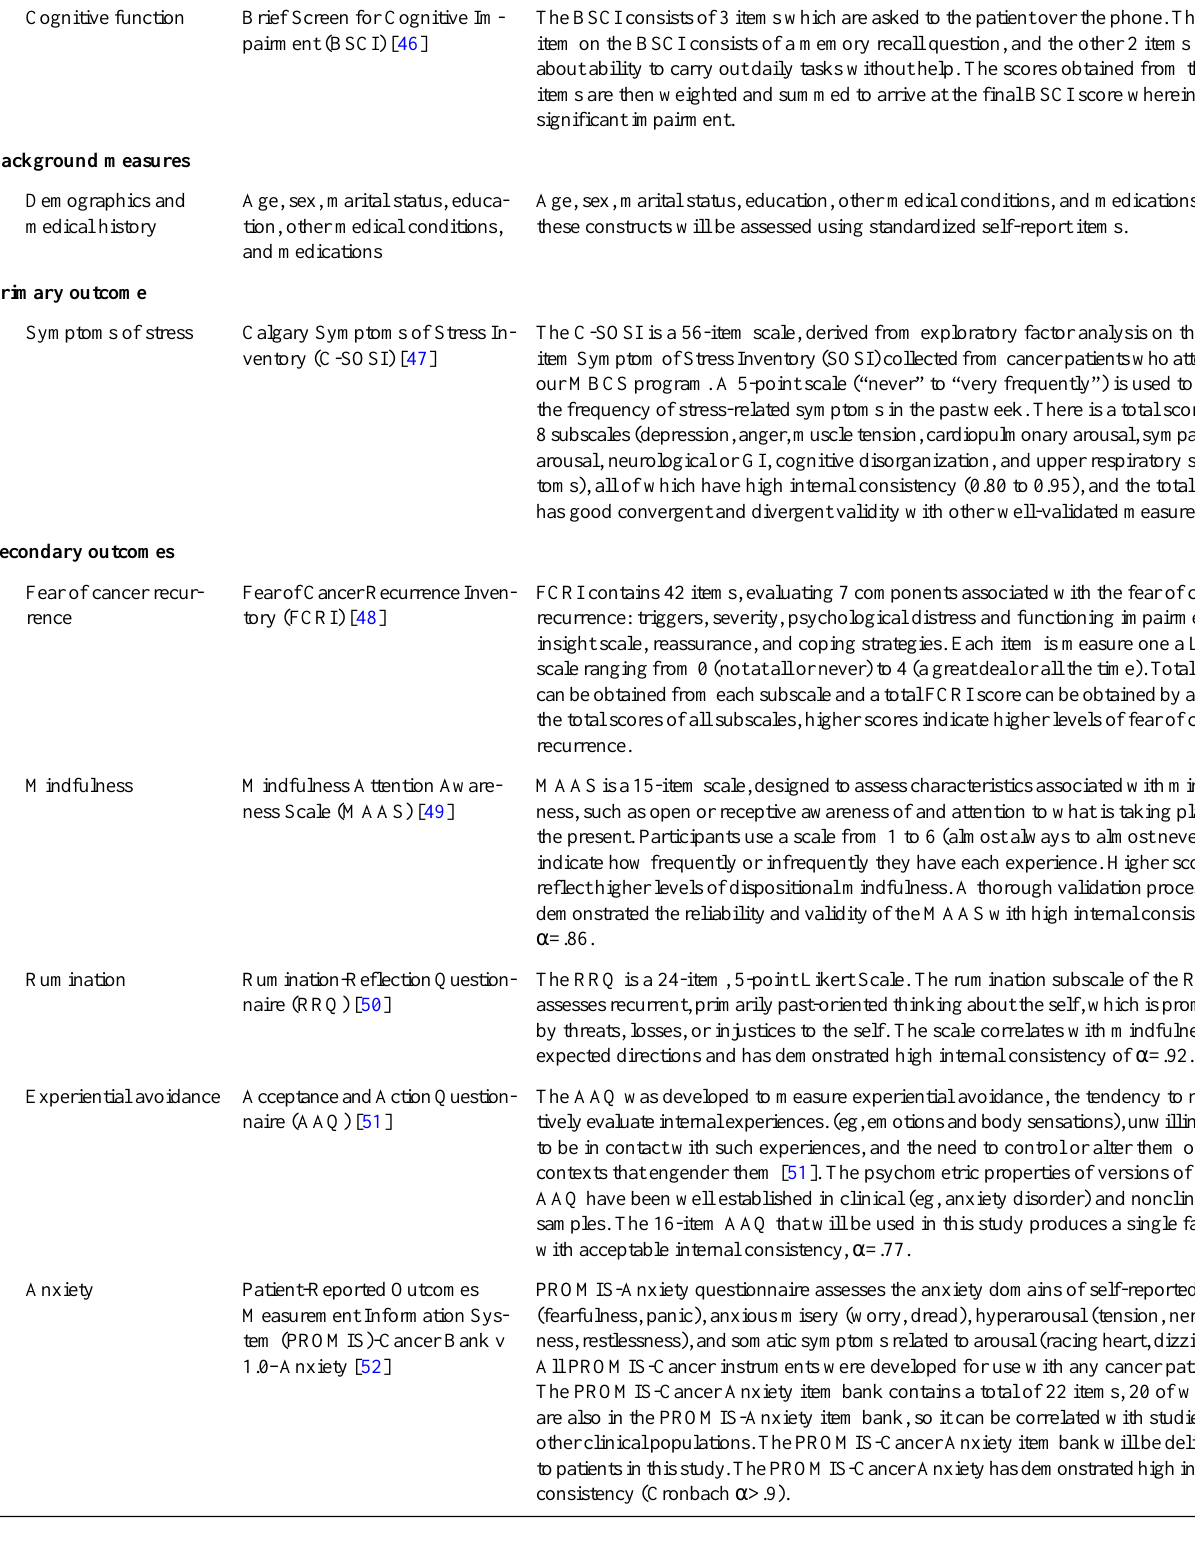
Table 3. Outcome